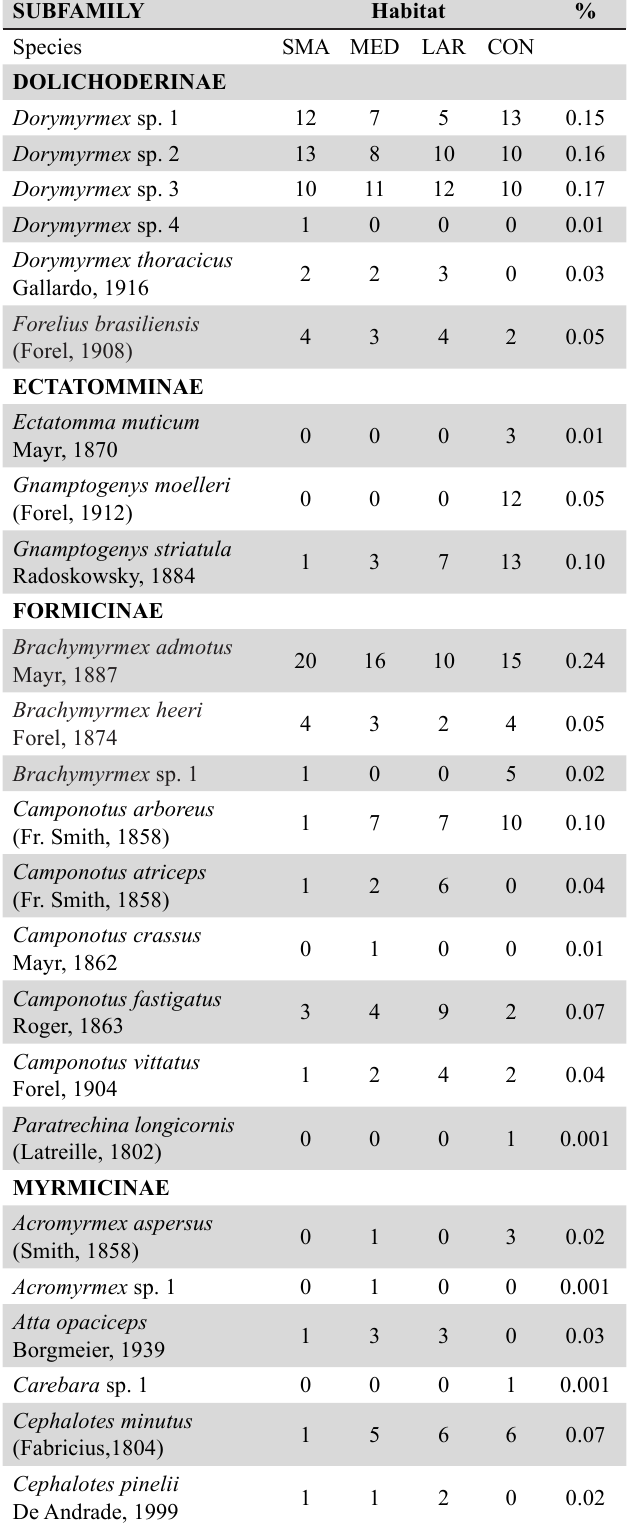
Table 2 . Ant frequency (0 - 100%), in small, medium large and continuous microhabitats in Parque das Dunas. SMA = Small, MED = Medium, LAR = Large, CON = Continuous